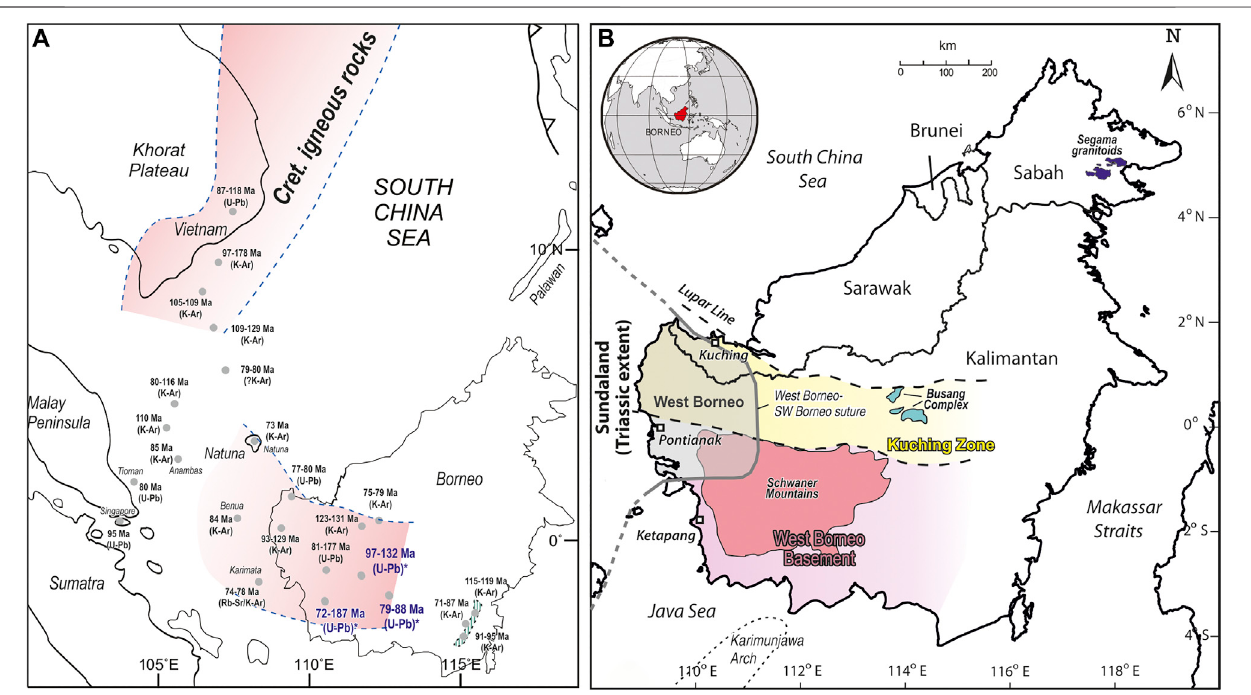
FIGURE 1 | (A) Cretaceous Paleo-Paci fi c subduction zone and spatial distribution of Cretaceous igneous rocks. Main belt with Lower to Upper Cretaceous granitoids extends from SE China and Taiwan in the north into SW Borneo in the south. A second smaller with predominantly Upper Cretaceous granites is located in centralBorneoandextendstoNatunaIslandandtheoffshoreSouthChinaSearegion.Locationsmarkedindarkblueandwith*aresamplesofthisstudy.Literaturedata assembled from Haile (1970), Haile and Bignell (1971), Priem et al. (1975), Hamilton (1979), Hutchison (1989), Bladon et al. (1989), Areshev et al. (1992), Wu and Yang (1994),Rustandiet al.(1995),Nguyen etal.(2004),Searleetal.(2012),Hartono(2012),Shellnuttet al.(2013),Henniget al.(2017),andLietal.(2018). (B) Tectonic zonesofwesternBorneoandlocationoftheSchwanerMountains(modi fi edafterHaile,1974;Hennigetal.,2017).TheWestBorneoBasementcorrelatesroughlytothe SW Borneo Block of Hall (2017) and Hennig et al. (2017). The old West Borneo Basement term (Haile, 1974) should be replaced in the future by the term SW Borneo to avoid